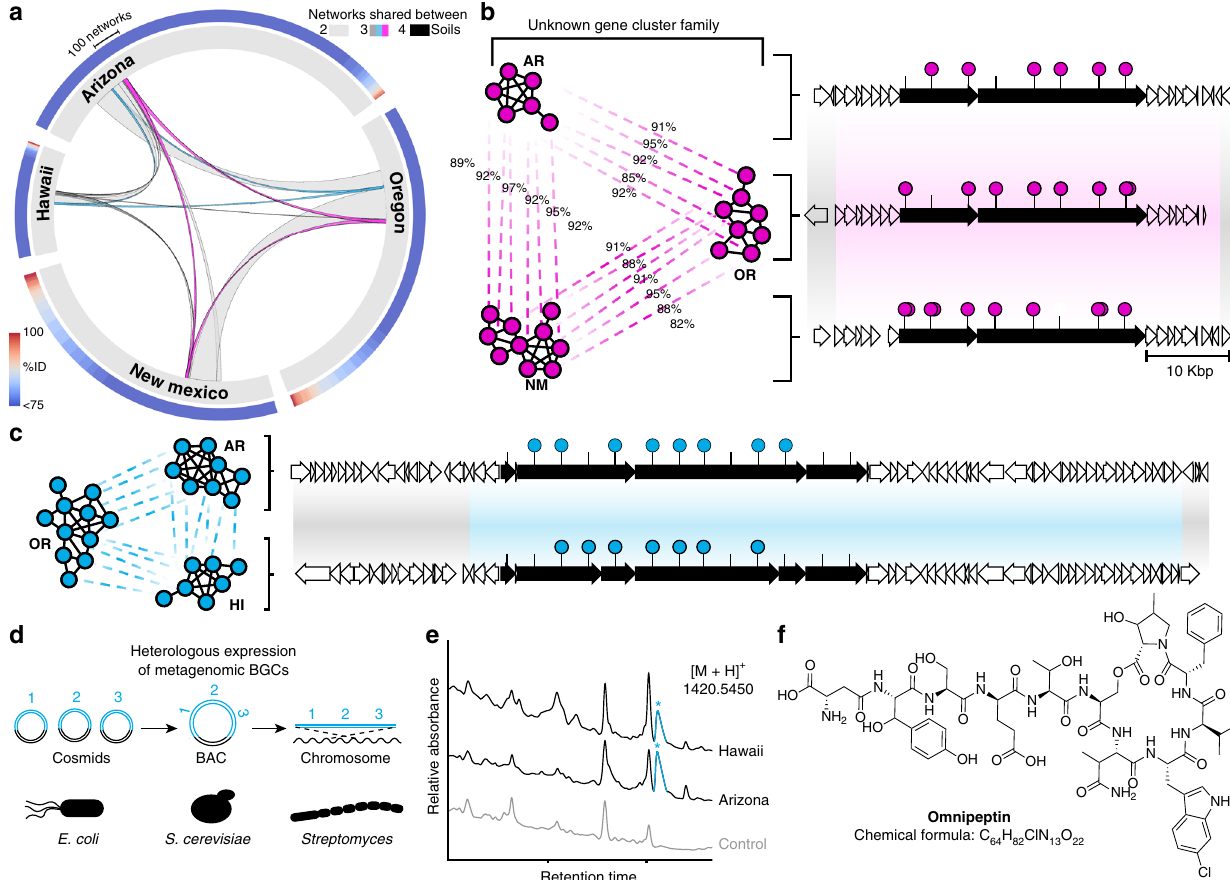
Fig. 3 Comparing domain networks from different samples enables discovery of common yet unknown families of natural products. a 3591 domain networks obtained from four soil samples were compared to each other and to sequences of BGCs found in databases. For each soil sample, the outer ring (red and blue) depicts the proportions of networks that display similarity to sequences of BGC found in databases. The fraction of networks found in each soil sharing relatives with a median identity higher than 90% in other soil samples is represented by the ratio of the width of the ribbons relative to the corresponding part of the inner ring (gray). Each ribbon represents the fraction of networks shared by combinations of 2, 3, or all 4 soils analyzed. Colored ribbons represent networks with close relatives in Oregon, Arizona and New Mexico (Magenta) or Hawaii, Arizona and Oregon (Cyan) out of which one representative family was physically recovered and depicted in b and c . b Detailed view of the pairwise comparison of biosynthetic domains belonging to related networks that form a family of common yet unknown BGCs. Recovery of metagenomic clones encoding this BGC family from geographically distant soils revealed novel and highly similar gene content and architecture. Colored shading covers the portion of metagenomic DNA showing high homology between related BGCs while gray highlight genes lacking signi fi cant homology that likely belong to independent chromosomal contexts outside of BGC boundaries. c CONKAT-seq networks and BGCs for members of a family of common yet unknown BGCs identi fi ed in Hawaii and Arizona soil samples. d The corresponding overlapping cosmids isolated from E. coli clones were assembled by transformation-associated recombination in S. cerevisiae into a bacterial arti fi cial chromosome (BAC) which was later integrated in the chromosome of Streptomyces albus . e Heterologous expression of the two related metagenomic BGCs and analysis of the associated crude extracts by HPLC/MS led to the detection of new peaks normally absent in the control extract obtained from the host native background ( S. albus) . f Both BGCs led to the isolation of the same major product, omnipeptin, a novel 11 residue